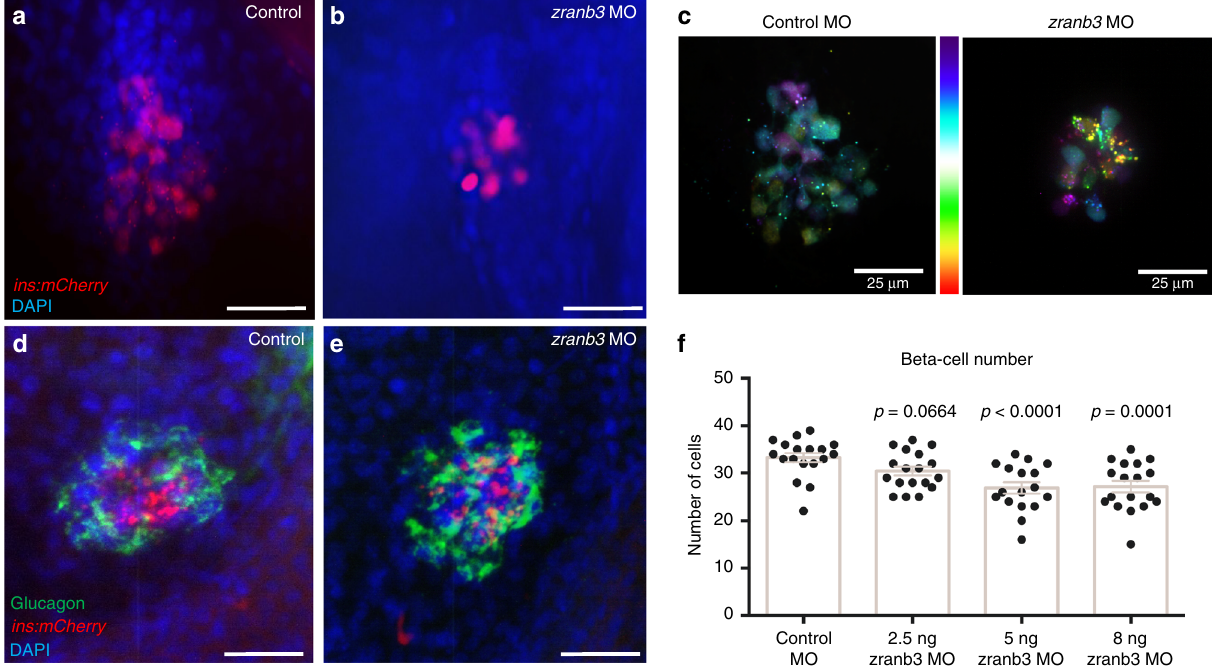
Fig. 4 Knockdown of zranb3 reduces β -cell number in zebra fi sh larvae. Injection of antisense oligonucleotide morpholinos (MO) targeting zranb3 reduced β - cells in 5 dpf larval zebra fi sh, detected by Tg( ins :mCherry) expression imaged via whole-mount confocal microscopy ( a , b ). c Depth coding of confocal microscopy images of whole-mount islets reveals individual cell resolution of β -cells in 5 dpf larval islets, color coded by depth (distal to proximal) along the z -axis. d , e Whole-mount immunostaining of MO-injected Tg( ins :mCherry) larval islets using antibody against glucagon (green). f Quanti fi cation of β -cell number in 5 dpf larval islets of Tg( ins :mCherry) injected with indicated concentrations of MO against zranb . ( n = 17 – 19). Bars represent average across groups. Error bars represent SEM. p Values are from the t test. Scale bars = 25 µ M